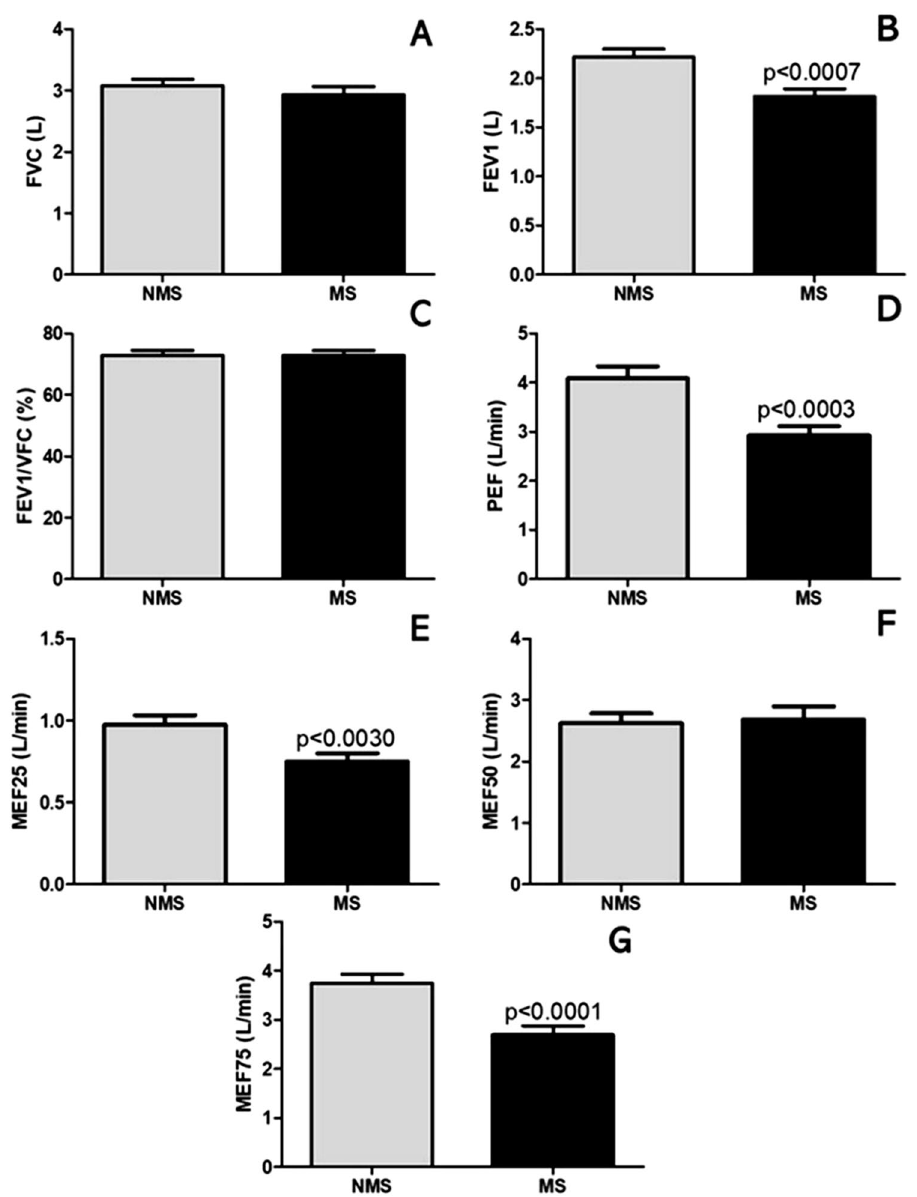
Figure 3. Spirometric parameters for lung function in older adults with and without metabolic syndrome (MS). Figure 3A (FVC), Figure 3B (FEV1), Figure 3C (FEV1/FVC), Figure 3D (PEF), Figure 3E (MEF25), Figure 3F (MEF50), Figure 3G